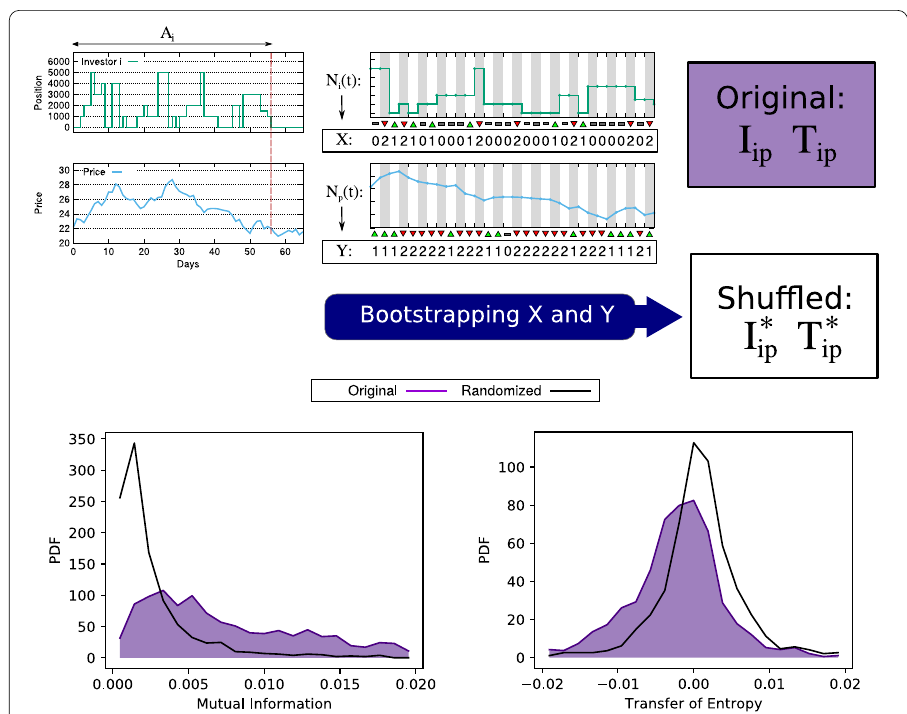
Figure 3 Measuring individual investors reaction to daily price fluctuations. (Top-left) From position time series of each investor i we determine the activity period A i . Instead of considering another investor, here we input the price time series p as the second numerical time series and proceed like in Fig. 1 for the symbolization process within that activity period. We compute Mutual Information I ip and Transfer of Entropy T ip between investor i and price p . Bootstrapping process is also applied here, to generate null distributions of I ∗ ip and T ∗ ip for standardizing original values, z ( I ij ) and z ( T ij ), and randomly selected null values z ( I ∗ ij ) and z ( T ∗ ij ). (Right) Distribution of standardized values of Mutual Information and Transfer of Entropy for original values (in purple area labelled “original”) and same null case values (white area labelled